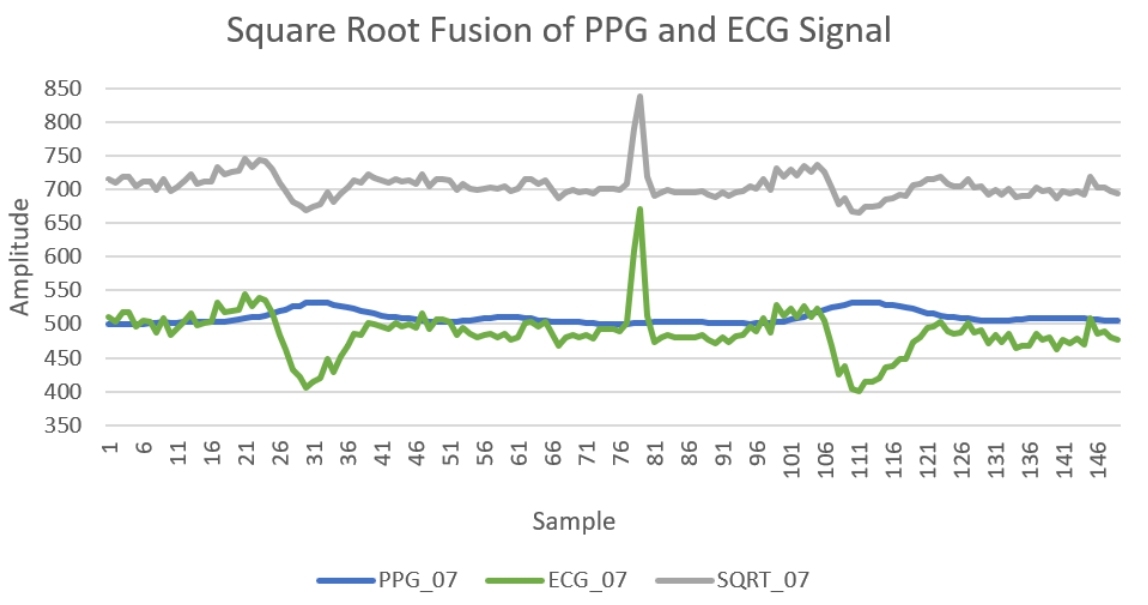
Figure 6. Photoplethysmogram (PPG), electrocardiogram (ECG) and fusion